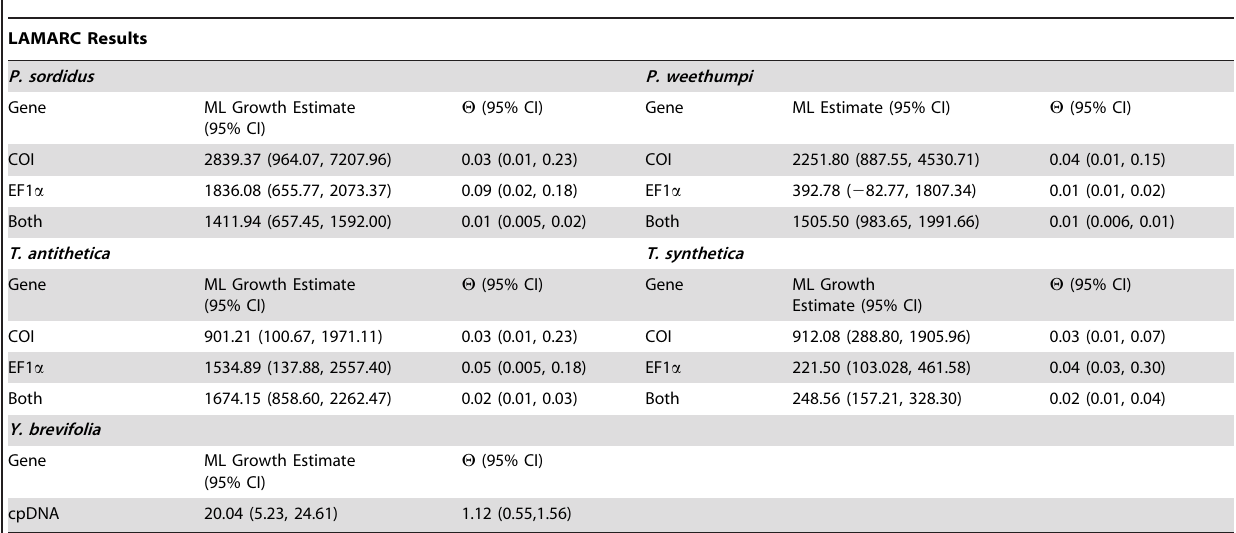
Table 4. Empirical estimates of population growth rates (scaled relative to the neutral mutation rate) and the population genetic parameter H estimated in LAMARC v. 2.1.2b